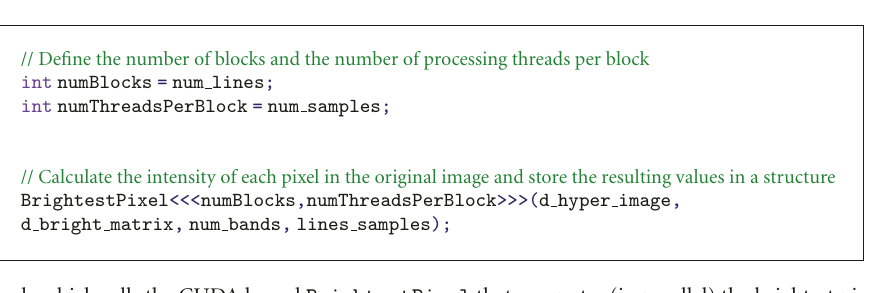
Figure 8: Portion of code which calls the CUDA kernel BrightestPixel that computes (in parallel) the brightest pixel in the scene in the G-ATDCA implementation.